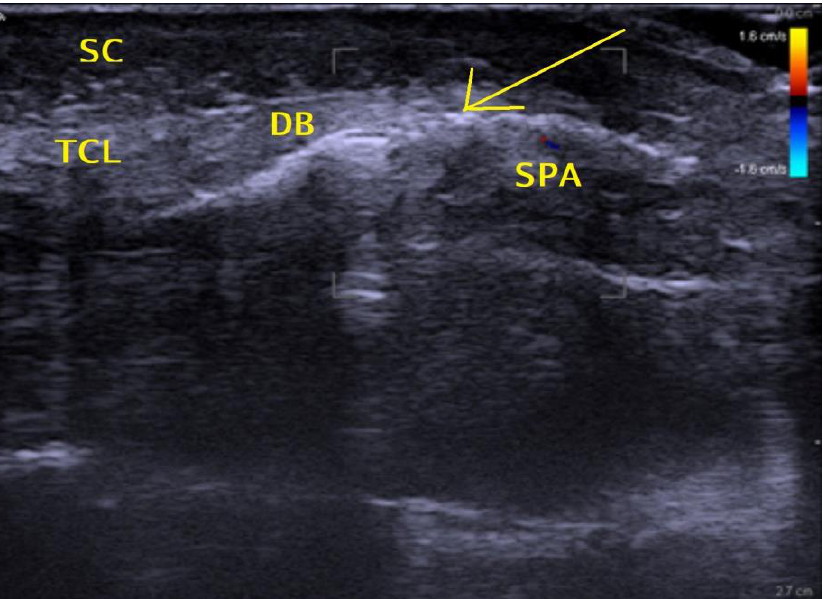
Figure 1. Sagittal distal palmar sonographic view. Arrow = distal needle insertion site; SC = subcutaneous tissue; TCL = transverse carpal ligament; DB = duck’s beak; SPA = superficial palmar arterial arch.